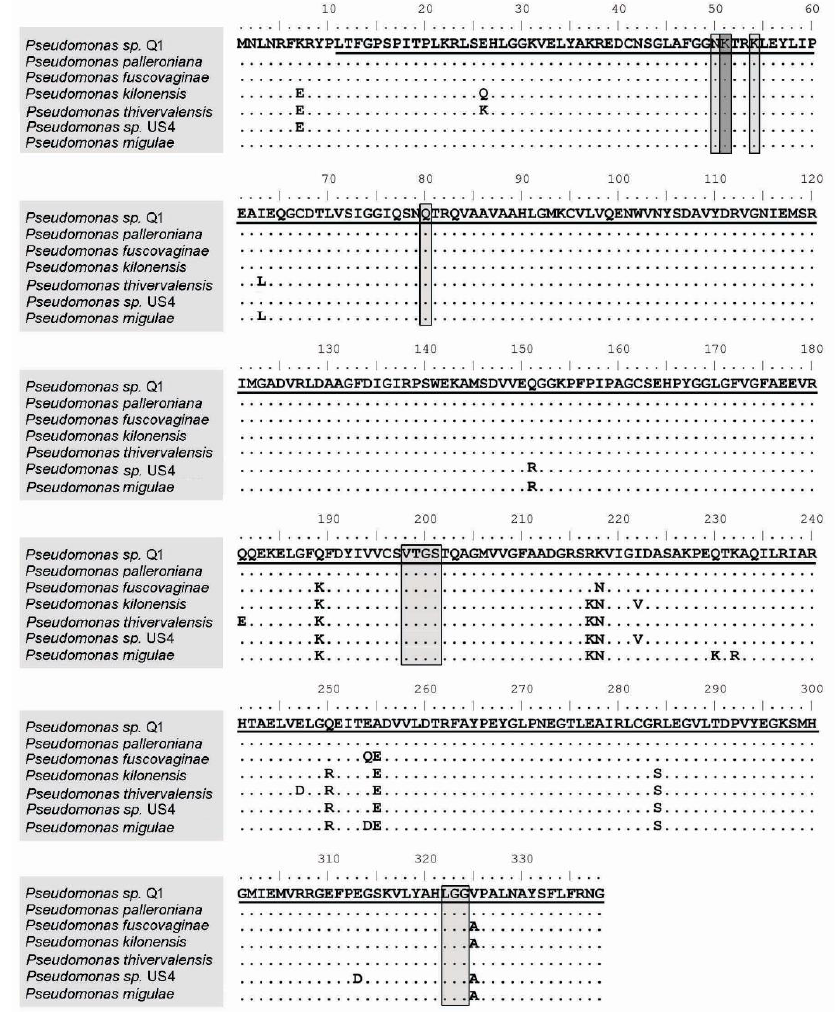
Figure 1. Alignment of AcdS protein amino-acid sequences from bacteria belonging to genus Pseudomonas . The conserved residues between all sequences are indicated by dots. The pyridoxal 5′- phosphate binding sites are indicated in light gray, and the catalytic residue is indicated in dark gray. The underlined amino acids correspond to the deletion fragment in Pseudomonas sp. Q1.